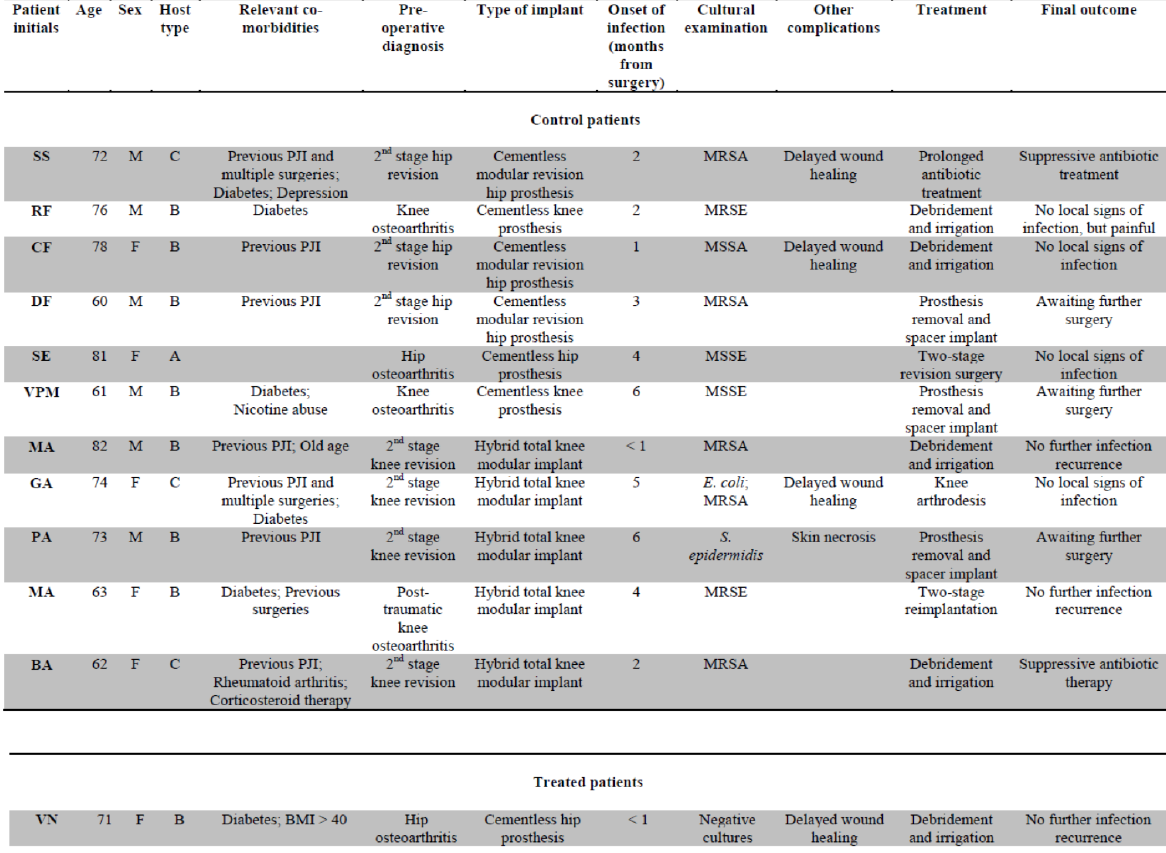
Table 5. Demographic and clinical characteristics of patients receiving total hip or knee replacement.